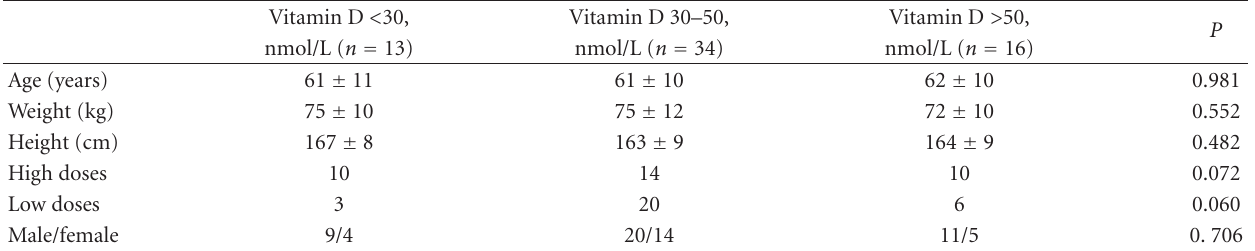
Table 1: Baseline patient characteristics according to vitamin D levels. High doses: atorvastatin (40–80 mg). Low doses: atorvastatin (10– 20mg).